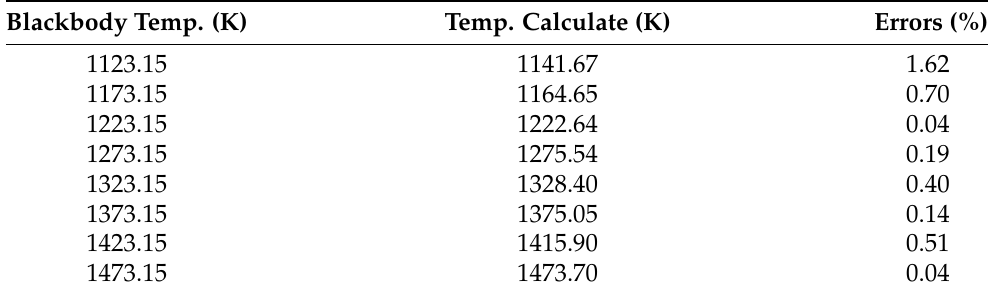
Table 2. Comparison of the Calculated Temperature with the Blackbody Furnace Using the cali- brated pyrometer.